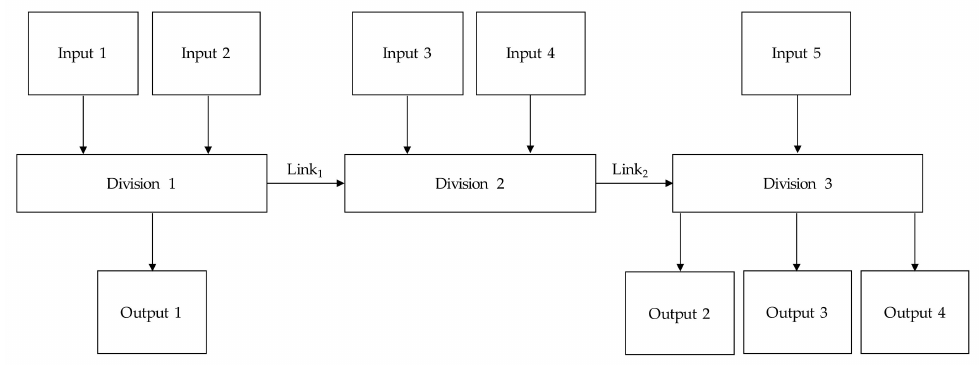
Figure 2. Structure Model of NDEA. Note: graphic adapted from Tone and Tsutsui [22].